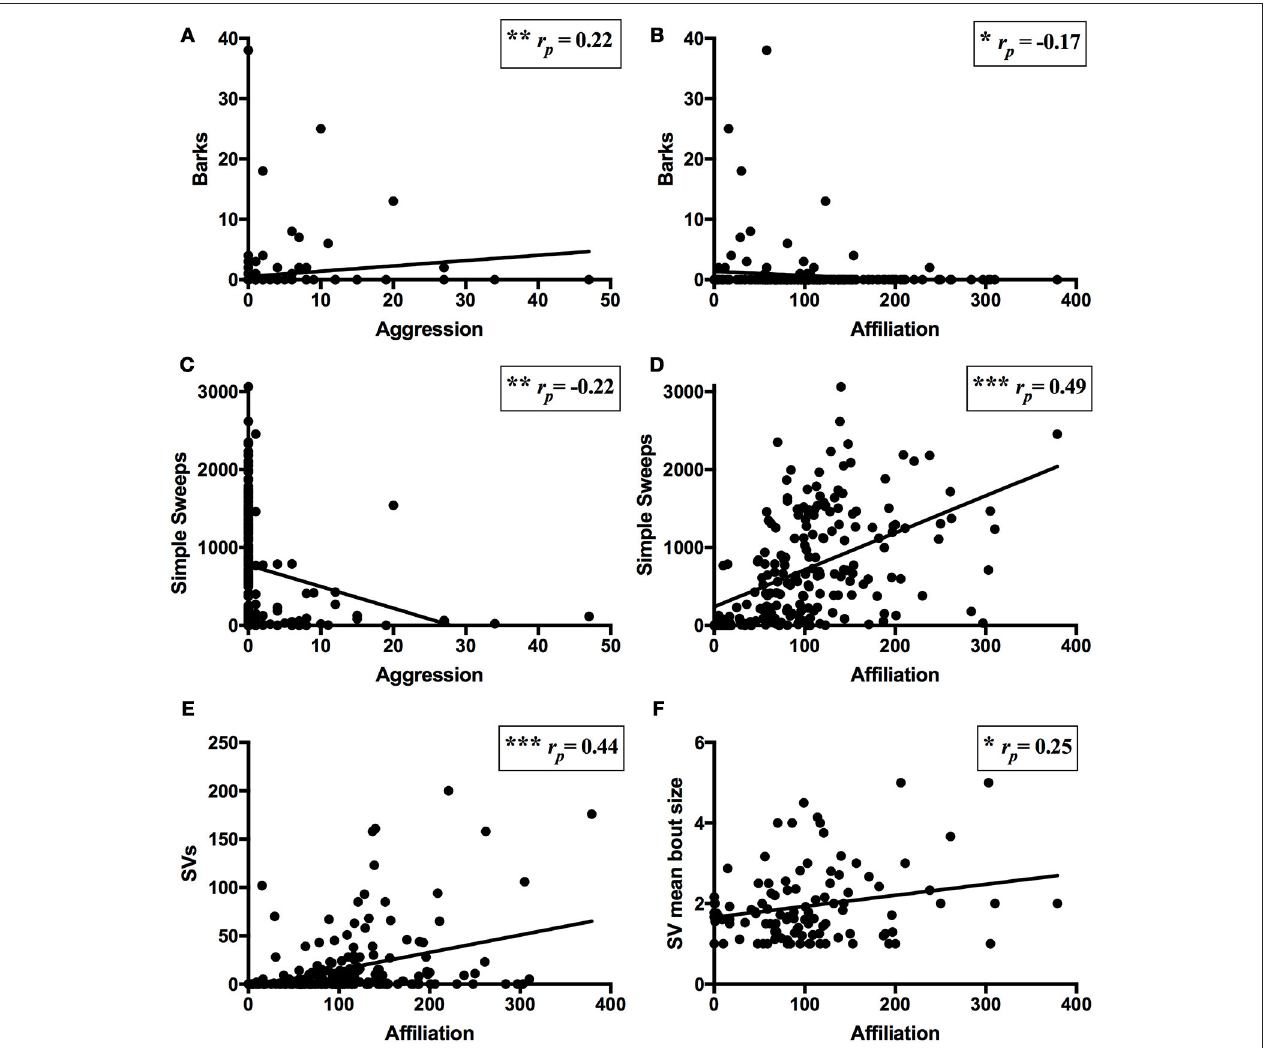
FIGURE 3 | Associations of USVs and pair behavior. Partial correlation (controlling for pair effects) between USVs and behavior for all trials within pairs over the course of the experiment [ N = 165 for (A–E) , N = 82 for (F) ]. (A) Positive correlation of barks and aggression (i.e., chases and wrestles). (B) Negative correlation of barks and affiliation (i.e., approaches, follows, and sniffs). (C) Negative correlation of simple sweeps and aggression. (D) Positive correlation of simple sweeps and affiliation. (E) Positive correlation of SVs and affiliation. (F) Positive correlation of SV mean bout size and affiliation among trials in which SVs were produced. Lines of best fit shown. * P < 0.05, ** P < 0.01, *** P < 0.001.